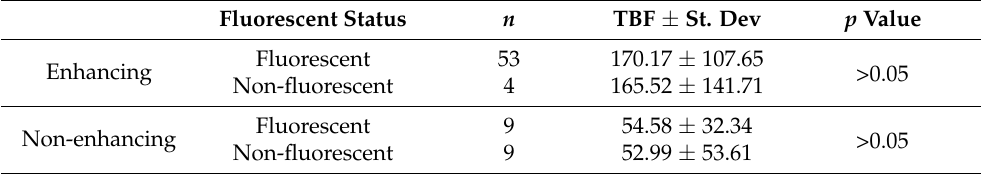
Table 4. The relationship between contrast enhancement, ASL perfusion and fluorescence.